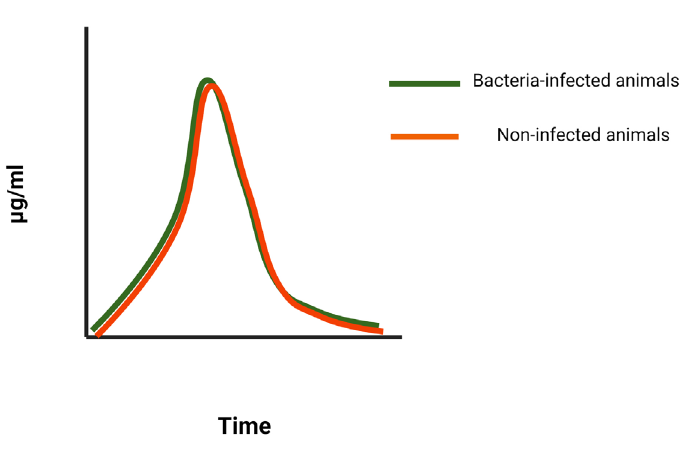
Figure 2B. Conceptual model of the kinetics of conventional antibiotics in blood and tissues. In comparison to bacteriophages, conventional antibiotics cannot replicate and are cleared from the system within the same time, regardless of whether or not a bacterial infection is present in